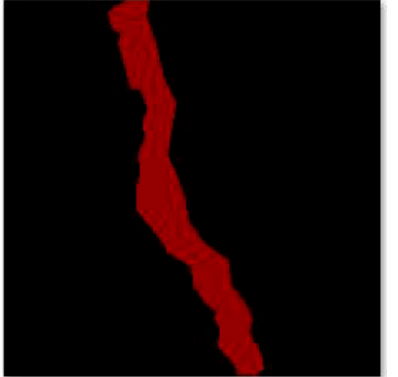
Figure 4. The 8-bit colour map with marked crack path and